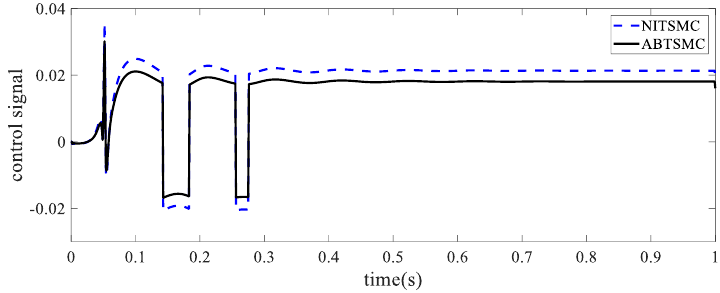
Figure 6. Sliding surfaces of ABTSMC and NITSMC.